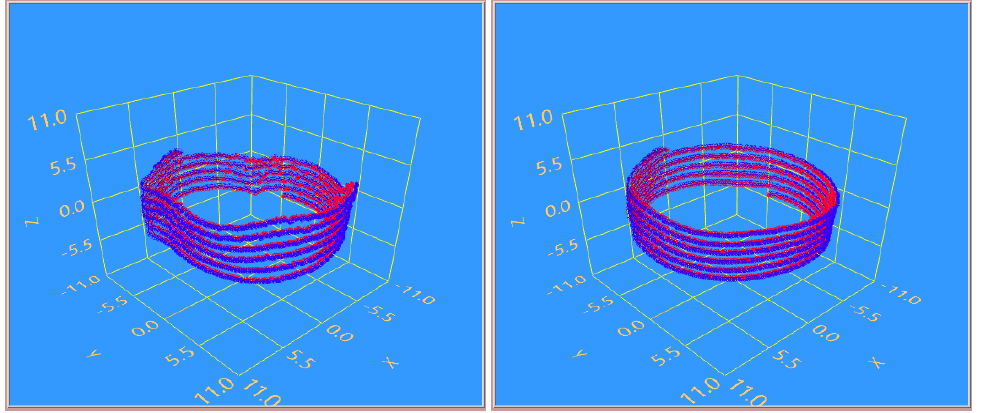
Figure 4. 3D views of reconstructed helix trajectory, the axes units are expressed in mm. The magnet is radially oriented and follows a helix trajectory 10 mm in radius and 1 mm in pitch, around the z axis. Beside the spatial position the tracker retrieves the dipole vector: red-blue dots are used to represent this data. The left tracking is obtained by 9P and suffers of evident (nevertheless submillimetric) distortions of the z co-ordinate. The right tracking uses the same magnetometric data, but a 8P analysis.